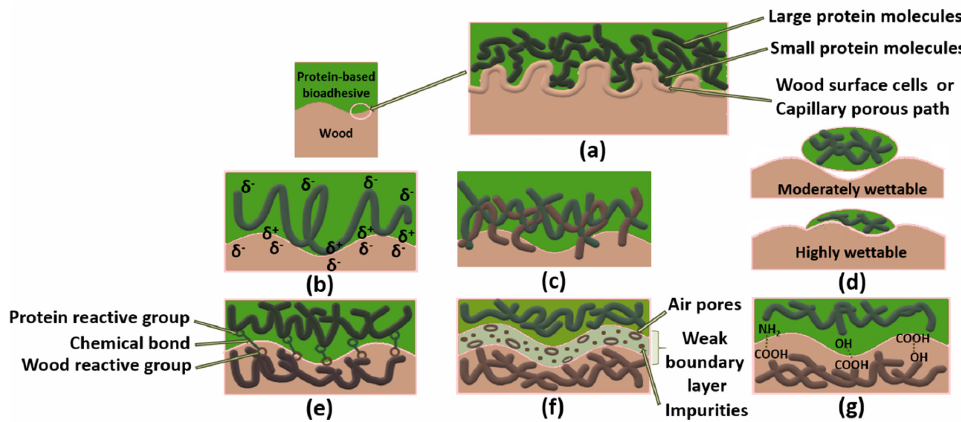
Figure 2. Adhesion theories in protein–wood adhesive bonding, mechanical interlocking ( a ), electrostatic ( b ), diffusion ( c ), wettability ( d ), chemical ( e ), weak boundary layer ( f ), acid-base ( g ). (Adapted from: [81,82]). Even if, usually, each phenomenon contributes to the whole strength of adhesion, in the case of wood, the primary adhesion mechanism includes interfacial secondary inter- actions such as van der Waal’s forces, dipole–dipole interactions, and H-bonding [83,84]. This implies that the two main theories involved in the case of wood bonding are generally the adsorption and acid-base theories. Although several researchers doubt the presence of covalent bonds with wood [82,83], some studies associate the adhesive strength of pro- tein-based systems with the existence of covalent linkages between the functional groups of the adhesive and those of wood [84–86]. This hypothesis is reasonable with some adhe- sives, especially when the formulations contain functional groups such as azetidine groups [87] and isocyanates [84,85], which can react with wood during curing conditions. Moreover, due to the porous structure of wood, it is generally accepted that some penetration of the adhesive from the surface leads to strong mechanical interlocking, ad- vantageously providing stronger bonding [82,83]. Therefore, under specific curing condi- tions, the combination of physical bonding and mechanical interlocking can further con- tribute to the overall bond strength in wood adhesion with protein-based adhesives. Read- ers who wish to gain an in-depth understanding of the interaction forces, adhesion mech- anism, and thermodynamics of adhesion are recommended to consult the references: [88,89]. To help understand the difference between the theories and mechanisms of adhe- sion, the possible mechanisms underlying each of these theories are schematically repre- sented in Table 2. Table 2. Adhesion theories and possible mechanisms. Theory